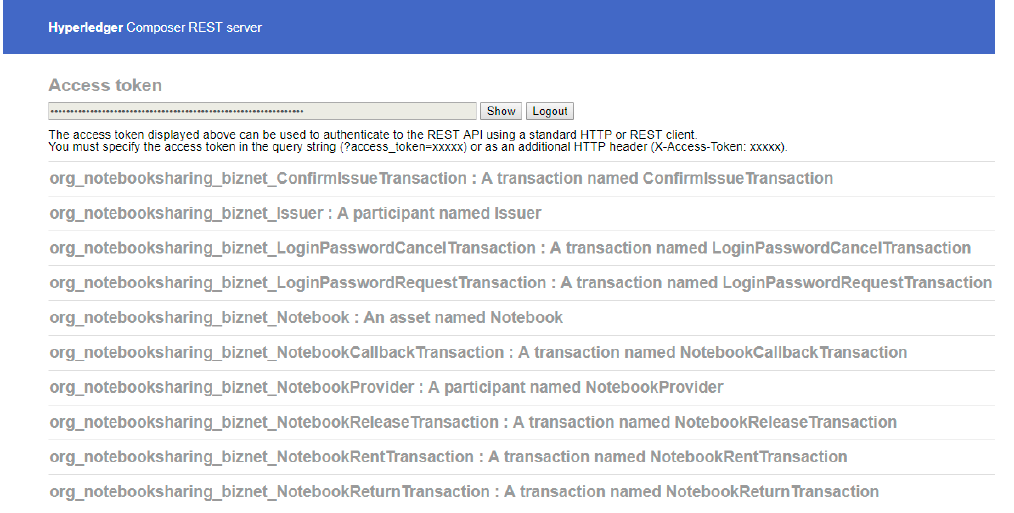
Figure 15. Composer REST Server explorer main